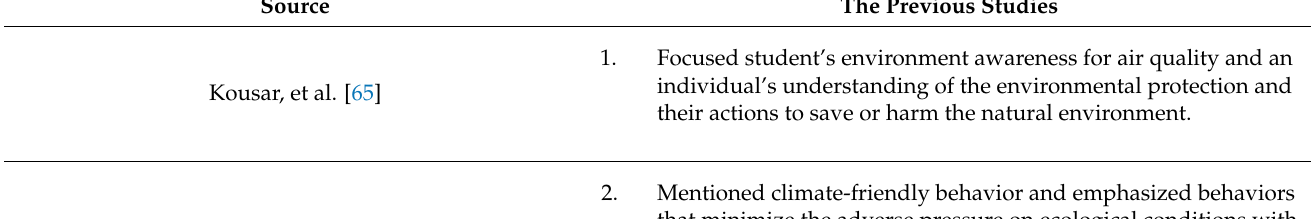
Table 4. The comparison of the strengths of this study with previous studies. Source The Previous